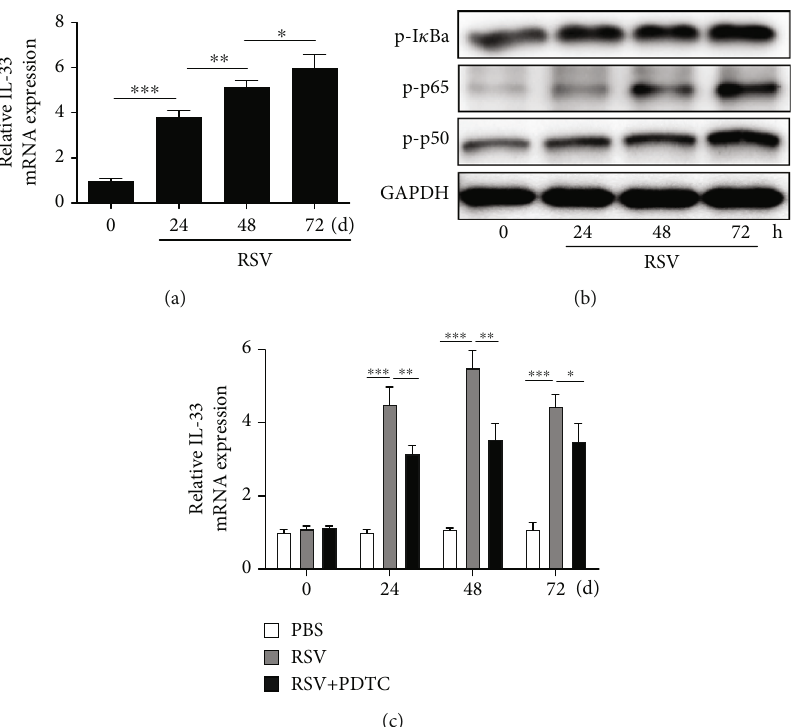
Figure 5: RSV-induced IL-33 expression was inhibited through NF- κ B pathway in vitro. (a) RT-PCR analysis was performed to examine the IL-33 expression in RAW264.7 cells at di ff erent time after RSV-induced. (b) Western blot analysis was performed to examine the abundance of I κ Ba, p65, and p50. (c) The IL-33 expression in macrophages at di ff erent times after RSV + PDTC treatment was examined by RT-PCR analysis. All data were expressed as the mean ± SD ( n = 3 ). Each value of ∗ p < 0 : 05 , ∗∗ p < 0 : 01 , and ∗∗∗ p < 0 : 001 was considered to be signi fi cant di ff